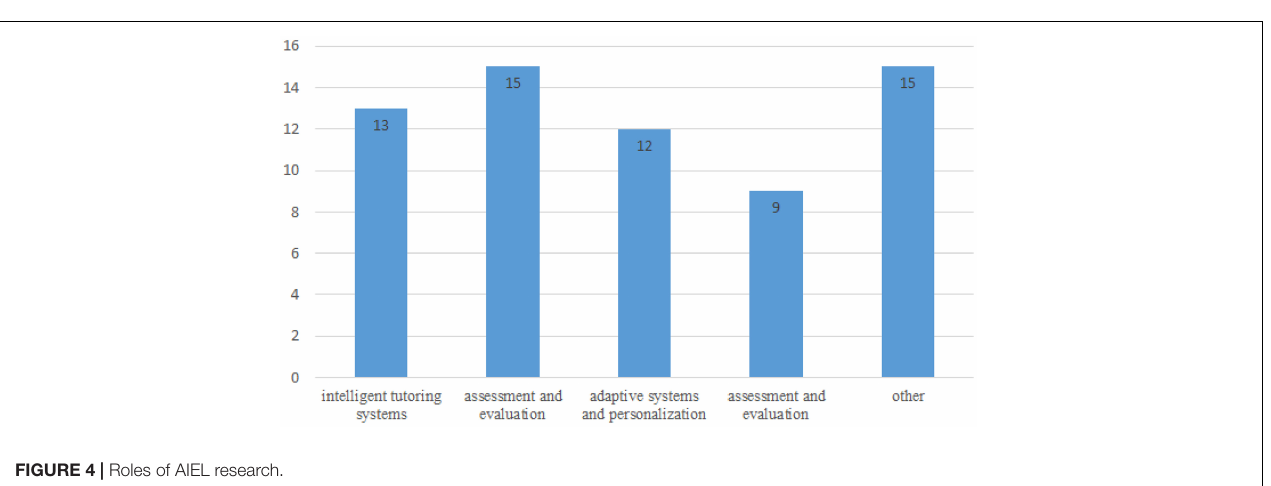
FIGURE 3 | Data distribution of AIEL co-authorship amongst countries from 2010–2021.